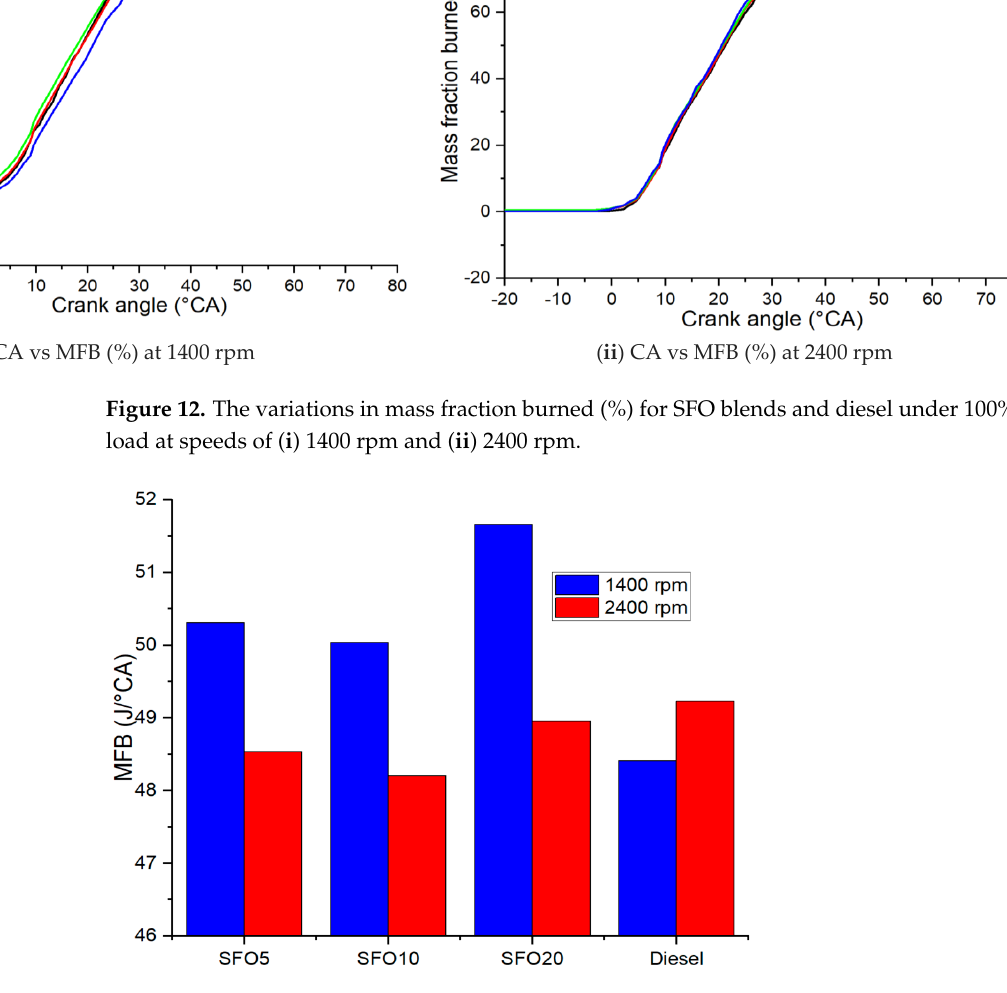
Figure 13. The average variation in the mass fraction burnt for different fuels at 1400 and 2400 rpm.